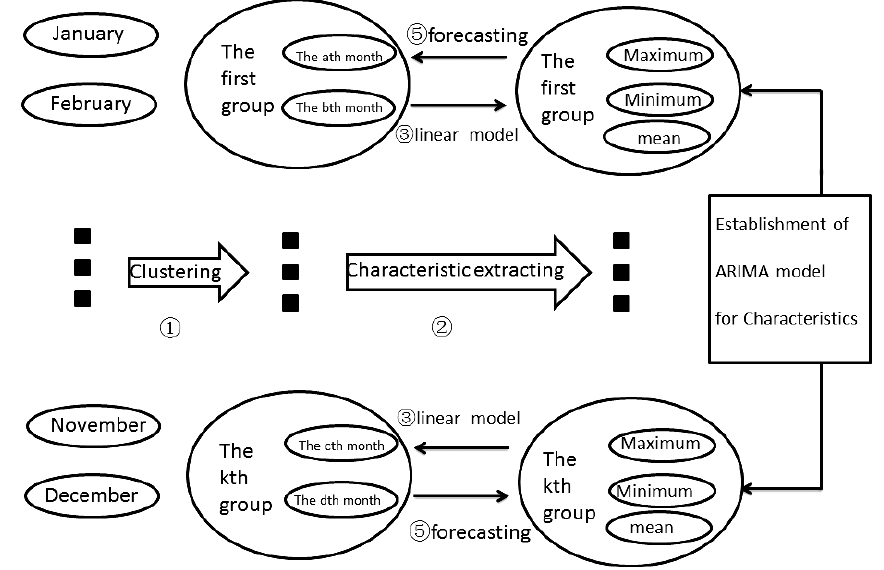
Figure 2. Prediction steps of a ARIMA model based on clustering and regressive